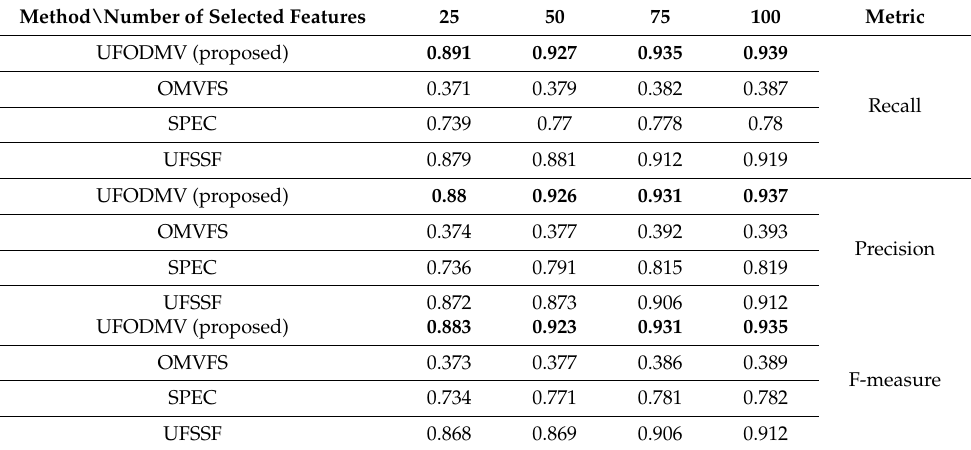
Table 6. Classification accuracy using Caltech dataset with IB1.